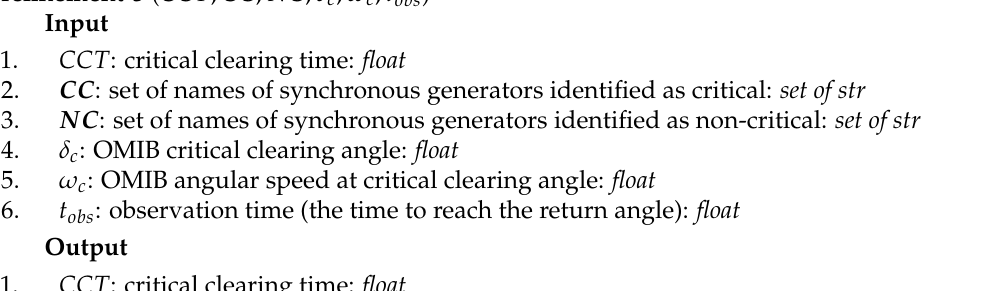
Algorithm A13 Third refinement scheme for